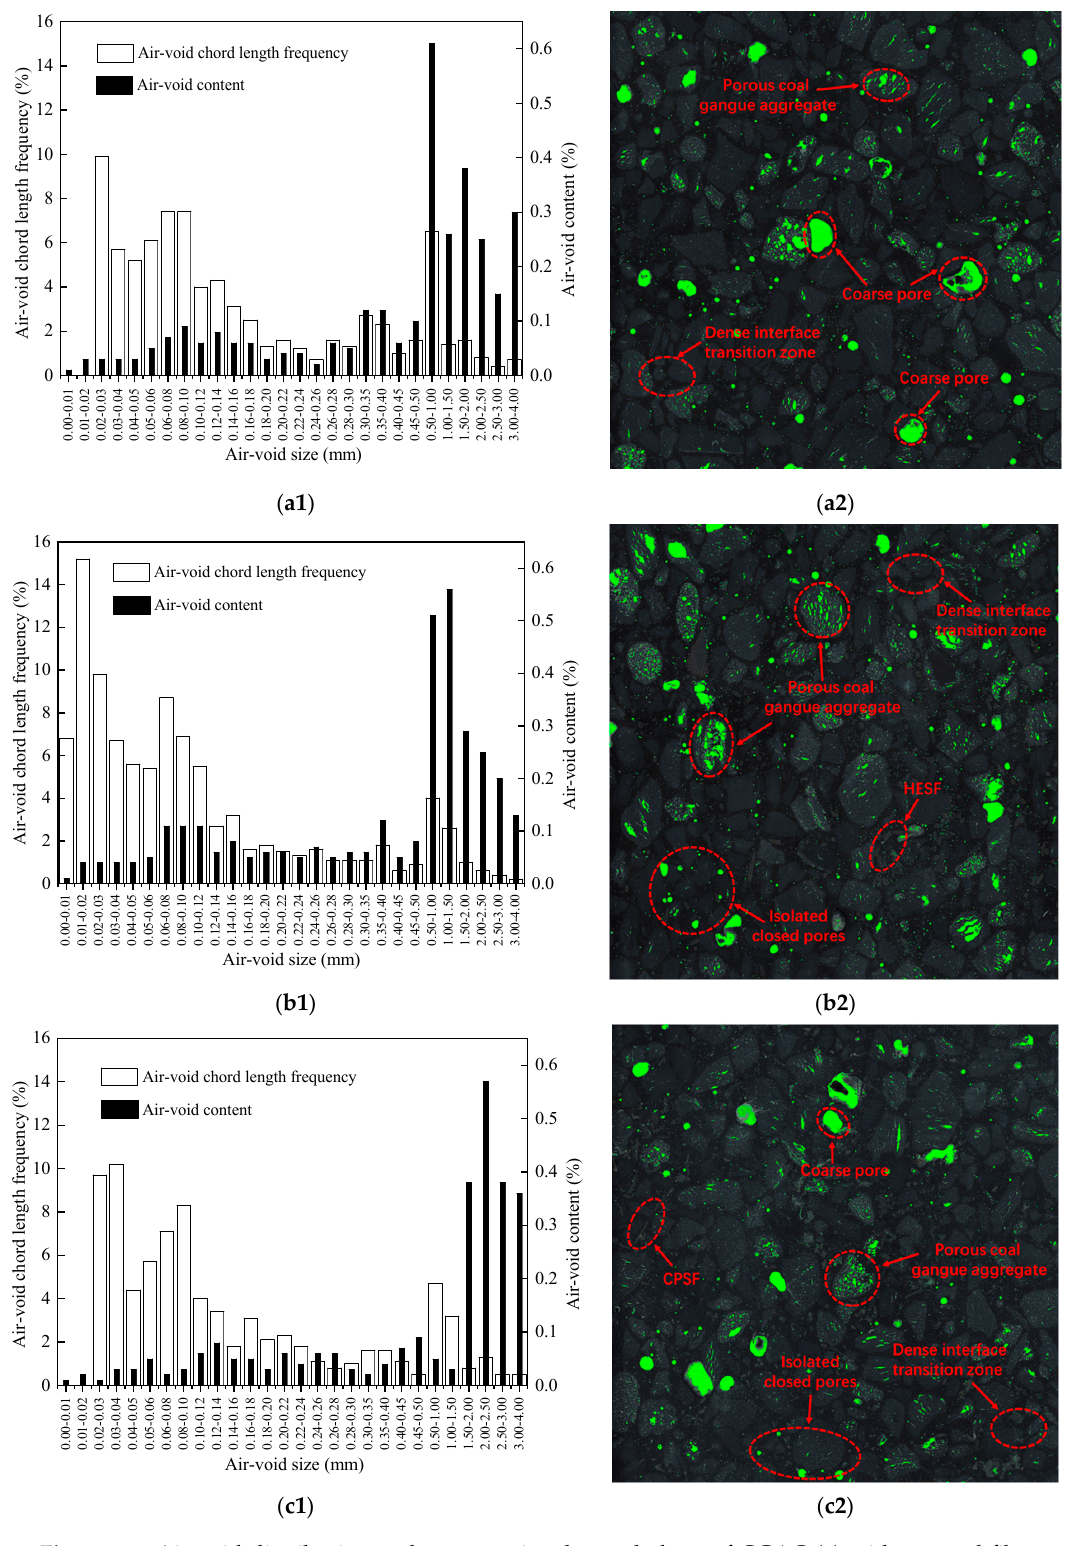
Figure 15. Air-void distribution and cross-sectional morphology of CGAC ( a ) without steel fiber; ( b ) with 1% HESF; ( c ) with 1% CPSF (1: Air-void distribution; 2: Cross-sectional morphology).